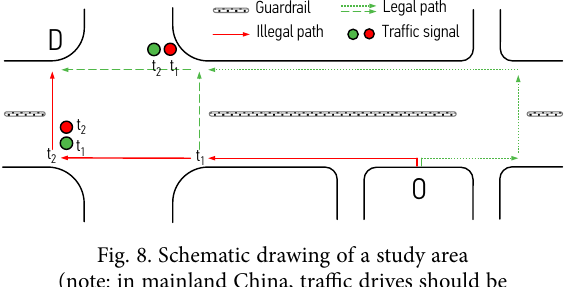
Fig. 8. Schematic drawing of a study area (note: in mainland China, traffic drives should be on the right-hand side of the